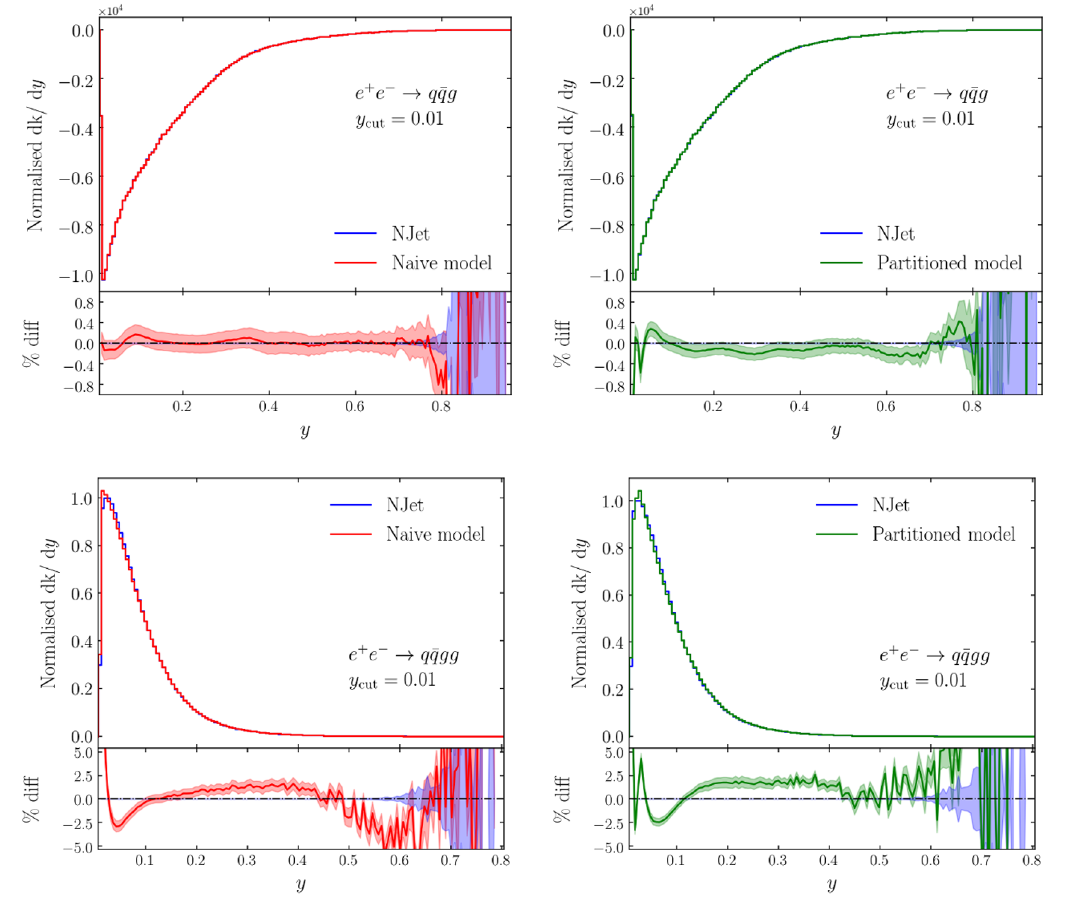
Figure 8 . Comparison of the naive approach (left) vs. the partitioned approach (right) in estimating the di(cid:11)erential NLO/LO k-factors against y , where y is the minimum y ij as ordered by p T . Data is normalised to the maximum Njet bin value. Uncertainty bands as described in (cid:12)gure 4.